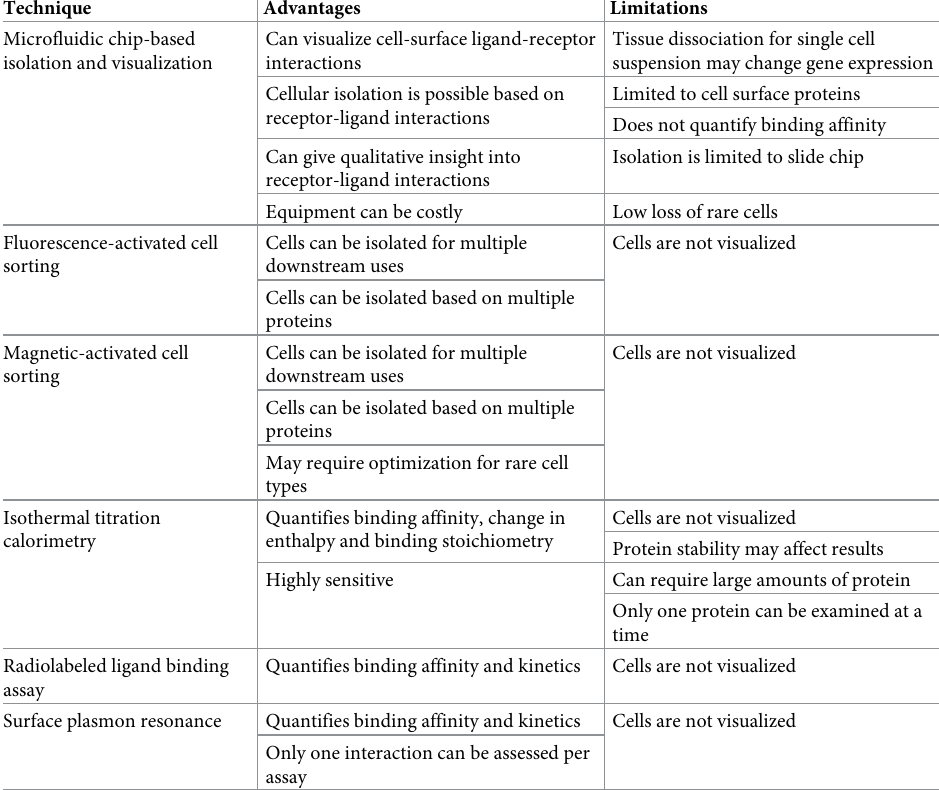
Table 1. Comparison of techniques for the analysis of cell-surface receptor-ligand